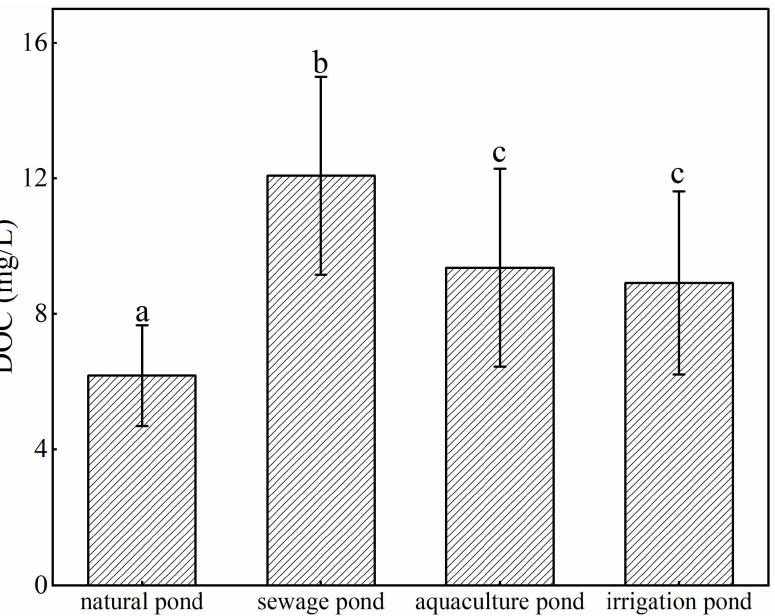
Figure 3. Spatial variations of DOC concentration in different ponds during sampling period. Error bars indicate standard deviation. Different letters indicate significant differences at p < 0.05 across pond